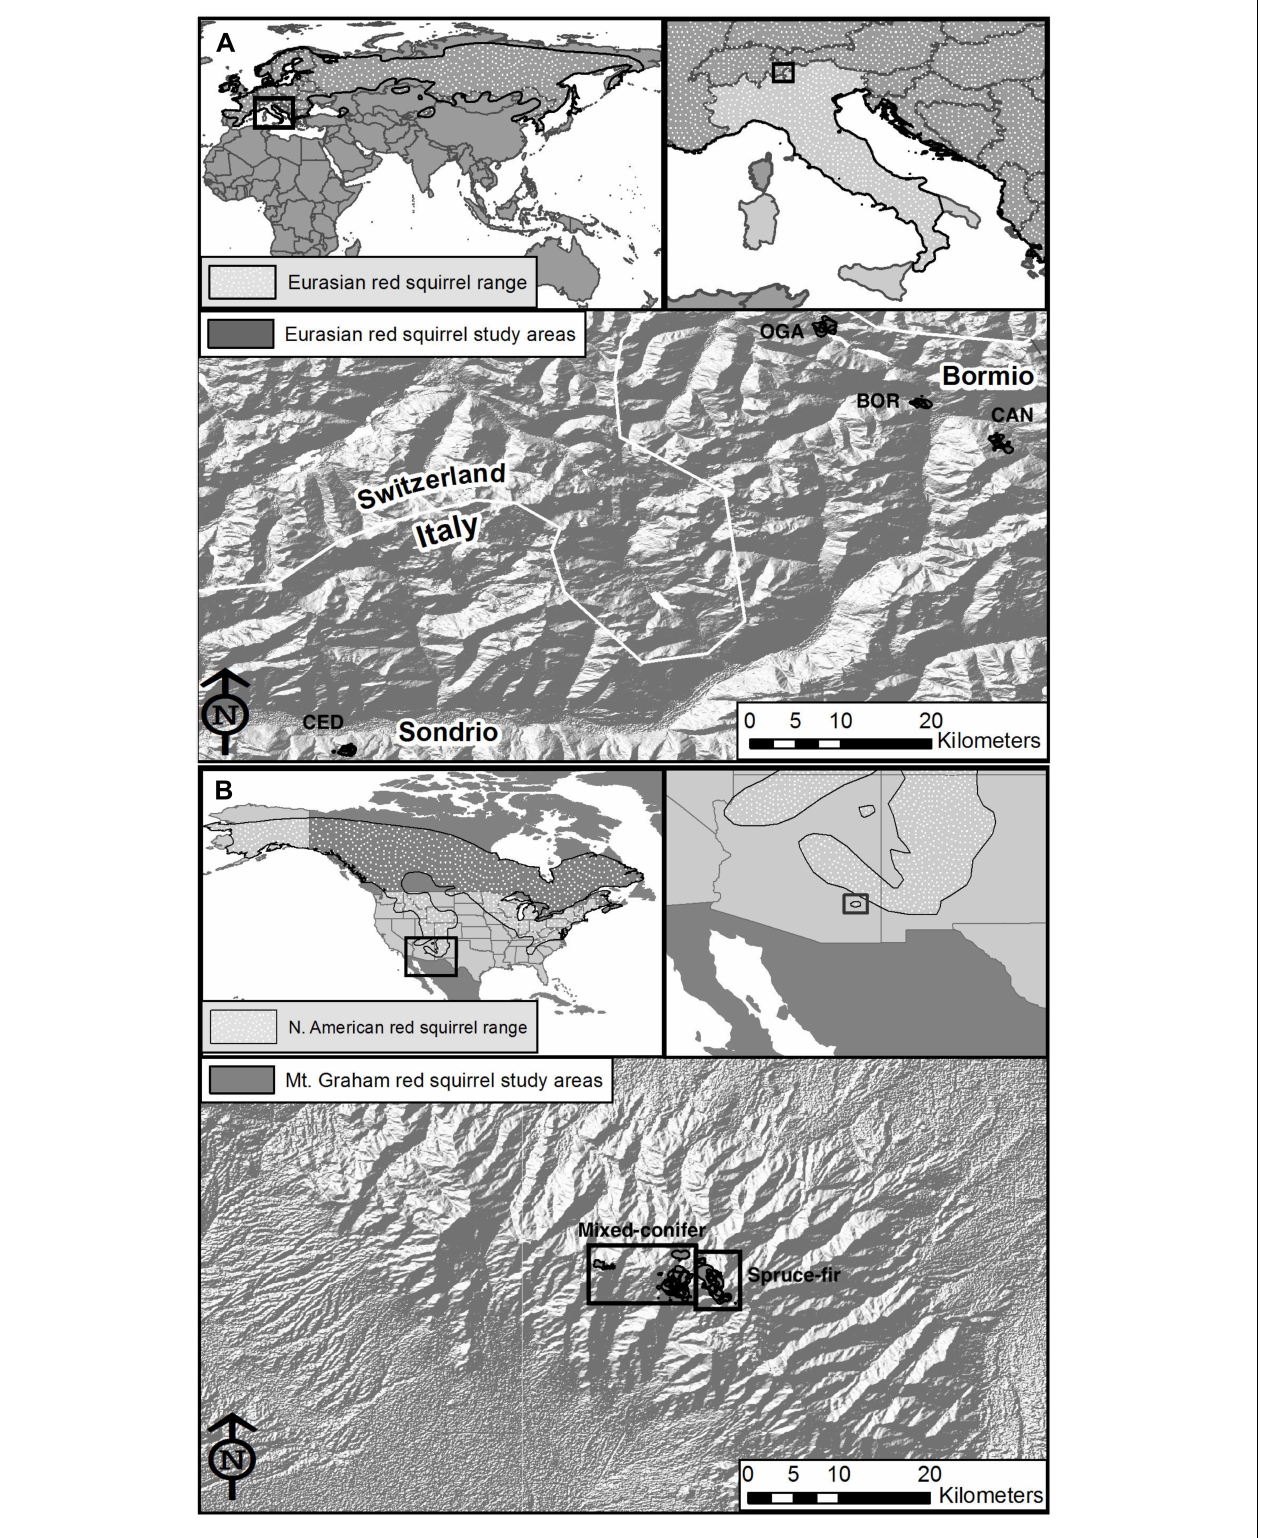
FIGURE 1 | Overview of study areas for Eurasian red squirrels ( Sciurus vulgaris ) in the central Italian Alps of Lombardy, Italy ( A , top) and Mt. Graham red squirrels ( Tamiasciurus fremonti grahamensis ) in the Pinaleño Mountains of southeastern Arizona, the United States ( B , bottom). Study areas are shown in relation to the geographic range of the species or, in the case of North American red squirrels, species group.